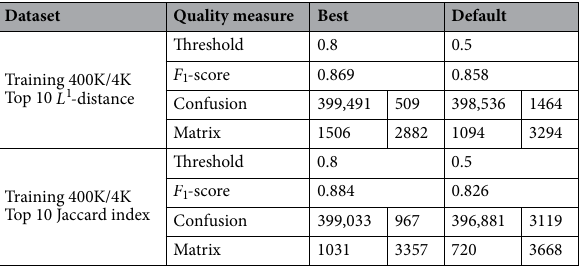
Table 9. Performance of synthetic traffic generated by standard WGANs by sampling generators with elitism among the top 10 models in training sorted by L 1 -distance and Jaccard index. Results on